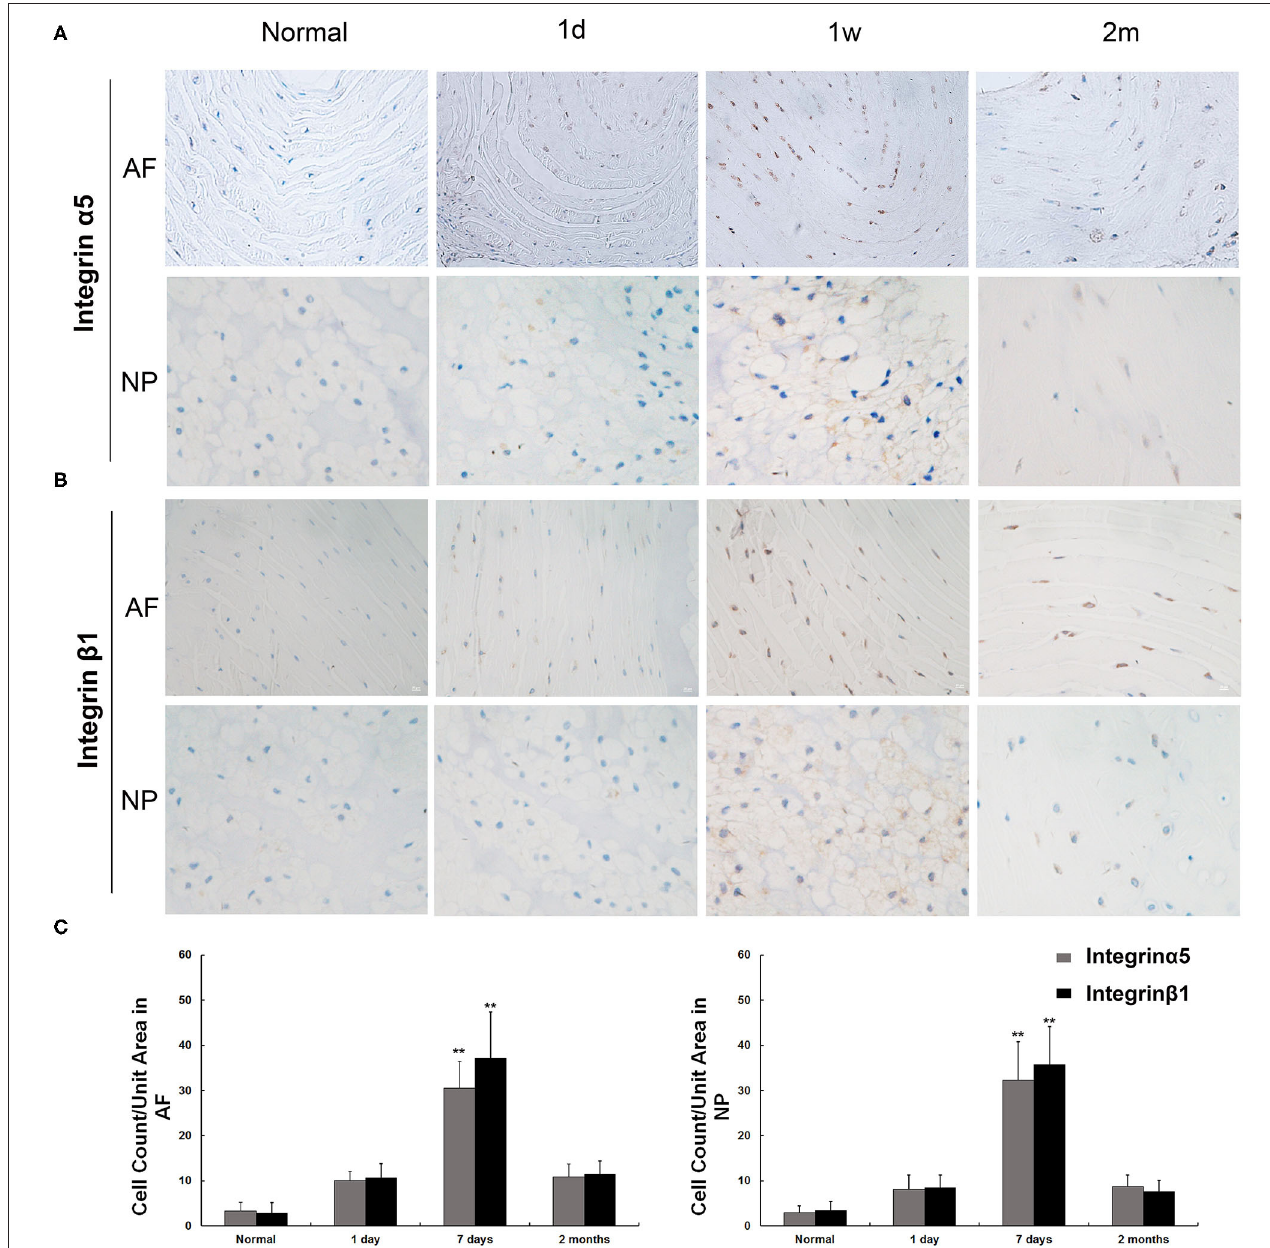
FIGURE 3 | Immunohistochemical staining of integrin α 5 and integrin β 1 in nucleus pulposus (NP) and annulus fibrosus (AF) cells. (A) The expression of integrin α 5 was observed in normal AF and NP cells. The increased expression of integrin α 5 appeared as early as 1 day postinjury, and the peak appeared at 7 days postinjury and remained visible until 60 days. (B) The expression of integrin α 5 was observed in normal AF and NP cells. The increased expression of integrin β 1 appeared as early as 1 day postinjury, and the peak appeared at 7 days postinjury and remained visible until 60 days. (C) Integrin α 5- and β 1-positive cells per unit tissue volume were plotted at various time points (1 day, 7 days, and 2 months) after rat disc puncture. ** p < 0.01 compared to normal disc and injured disc at 1 day and 2 months.